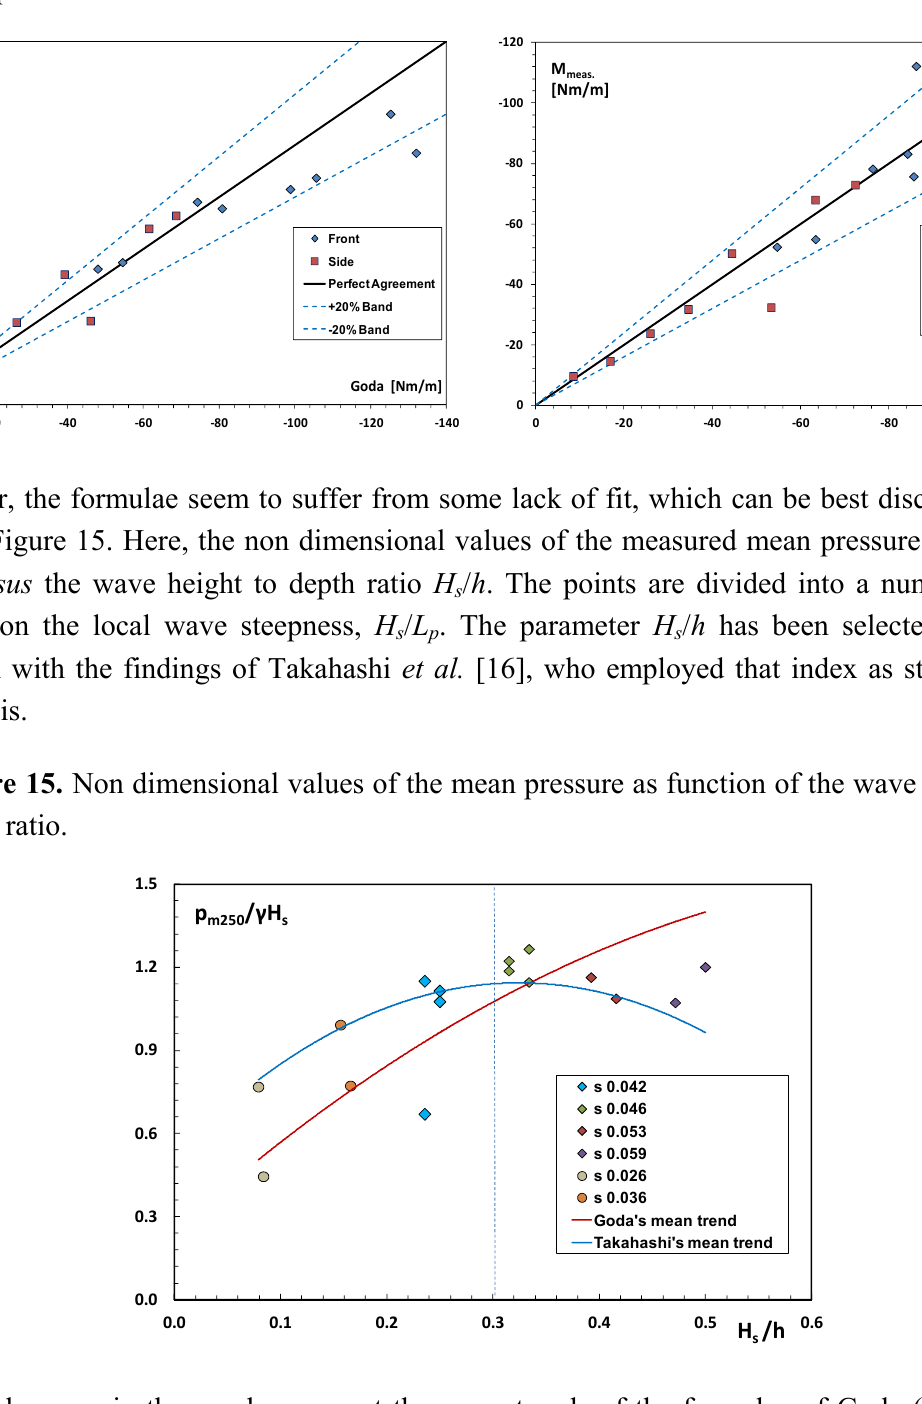
Figure 14. Measured vs. predicted torques at the structure heel. Left panel: Goda model; right panel: effect of Takahashi et al. correction.